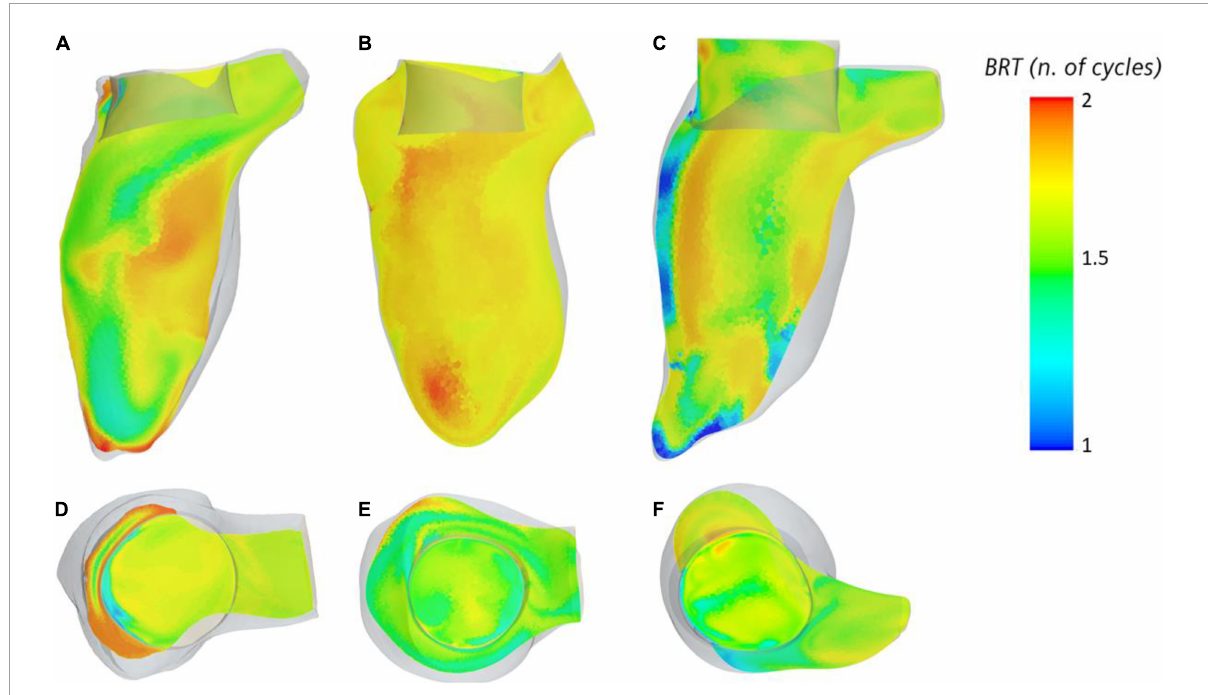
FIGURE5 (Wall shear stress-exposure time threshold for platelet activation. Comparison between experimental data from literature and simulation results (33–38).